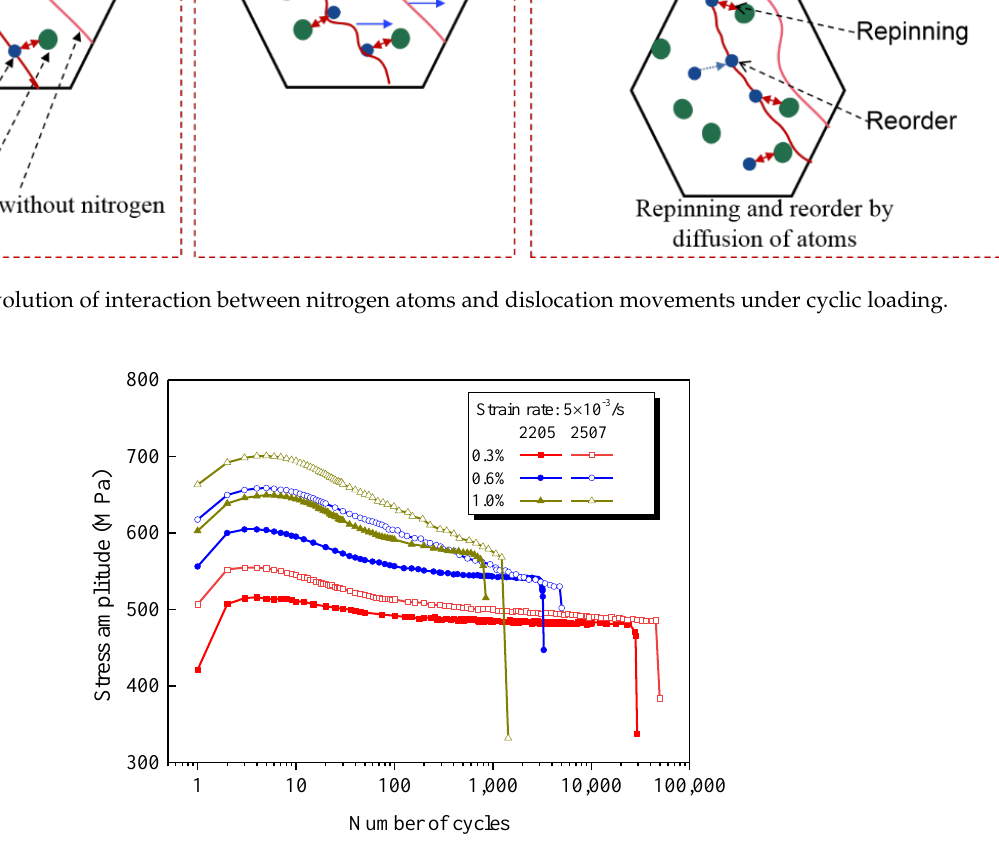
Figure 14. Comparison of cyclic stress responses of 2205 and 2507 under different strain amplitudes with a constant rate 5 × 10 −3 s −1.